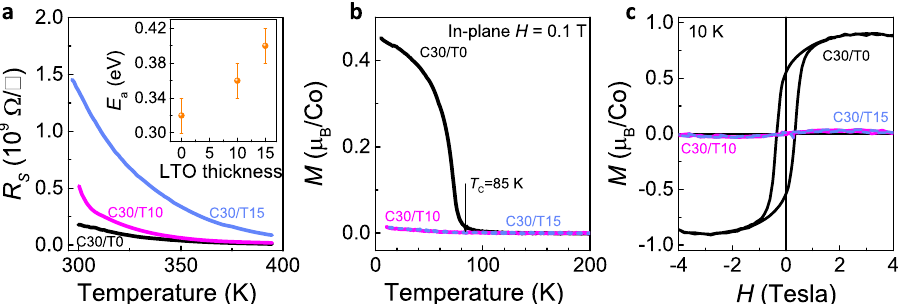
Fig. 4 Transport and magnetic properties of C30/T n . a Sheet resistance of C30/T n heterostructures as a function of temperature. The inset shows the activation charge gap of C30/T n . b Temperature dependence of magnetisation M ( T ) curves for C30/T n under fi eld cooling measured by applying an in- plane magnetic fi eld H = 0.1 Tesla. c Magnetic hysteresis loops M ( H ) measured at 10 K for C30/T n heterostructures. The saturation magnetisation reaches ~0.9 μ B /Co, evidencing the stoichiometric LCO of the C30/T0 30 . The disappearance of FM ordering in the La 3 Co 3 O 8 and La 2 Co 2 O 5 indicates an AFM